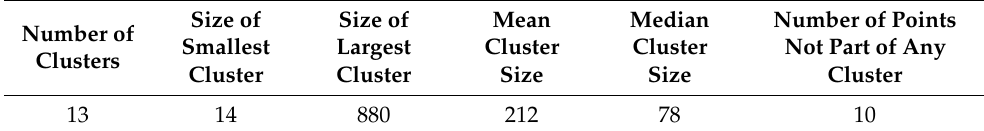
Table 2. Output of the distance-based clustering function in the central area of Antwerp: Lat ∈